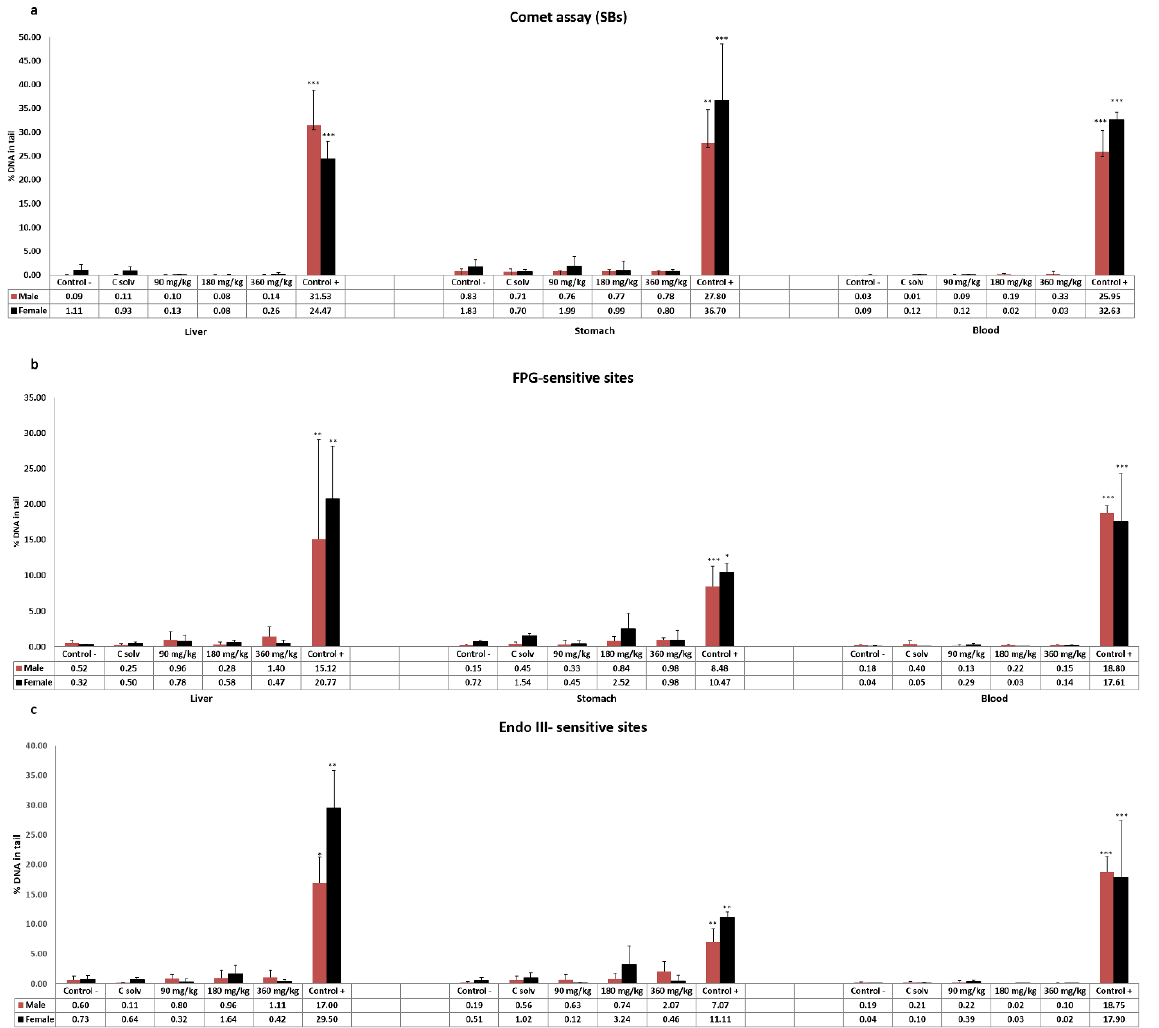
Figure 1. The level of DNA damage measured on cells isolated from liver, stomach, and blood of male and female rats exposed to ST-99 as the formation of strand breaks (SBs) by the standard comet assay ( a ), and oxidative DNA damage as Endo III-sensitive sites ( b ) and FPG-sensitive sites ( c ) by the modified comet assay. The levels of DNA strand breaks and oxidized pyrimidines/purines are expressed as % DNA in tail. All values are expressed as mean ± SD. The significant levels observed are * p < 0.05, ** p < 0.01, or *** p <